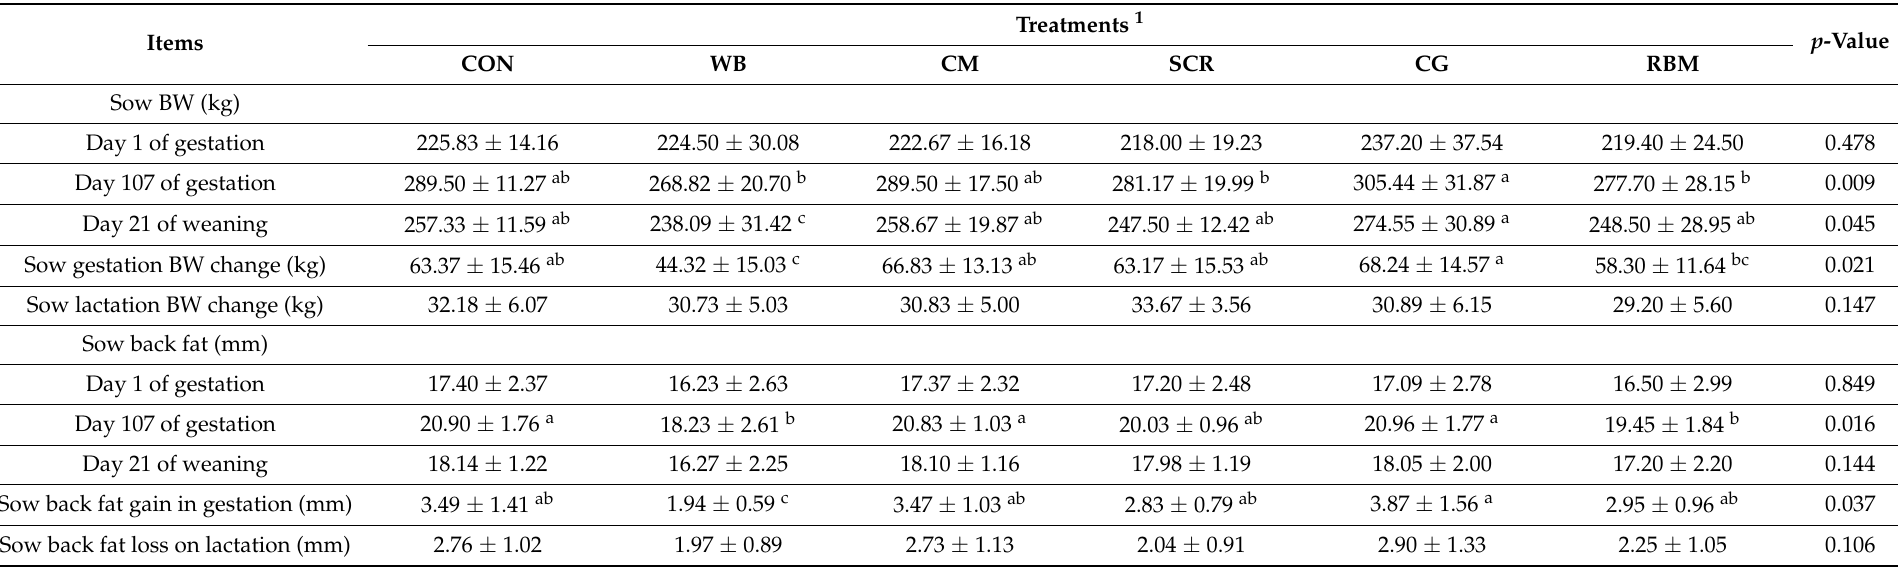
Table 3. Effects of different fiber sources on reproductive performance and body condition of sows during gestation and lactation.